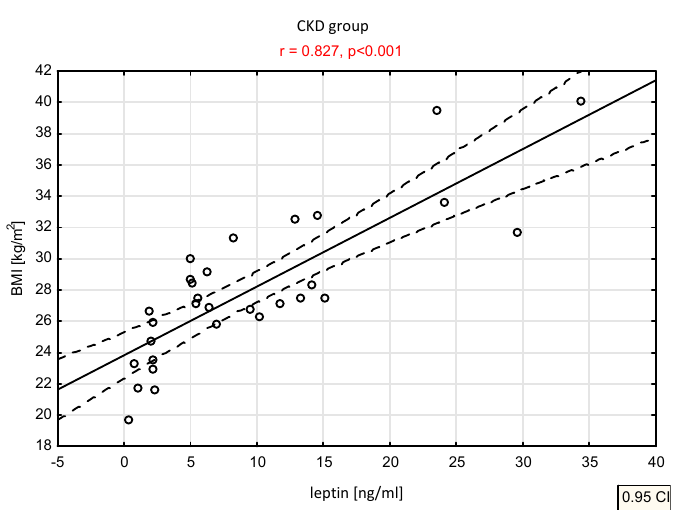
Figure 1. Correlation between leptin concentration and BMI in the CKD group.